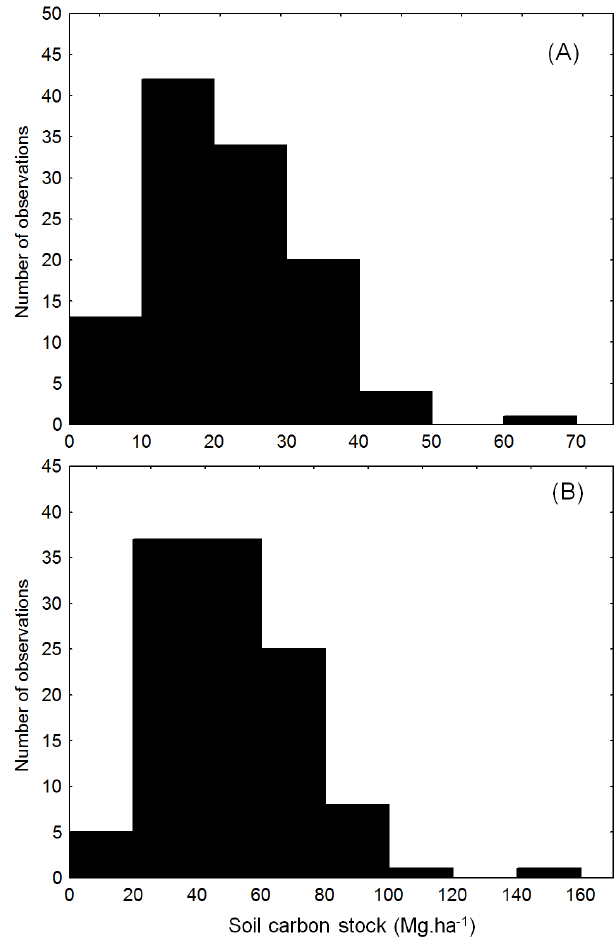
Fig. 5. Histograms of (A) soil carbon stock in the regional pasture sites at 0–10cm depth interval and (B) at 0–30cm depth